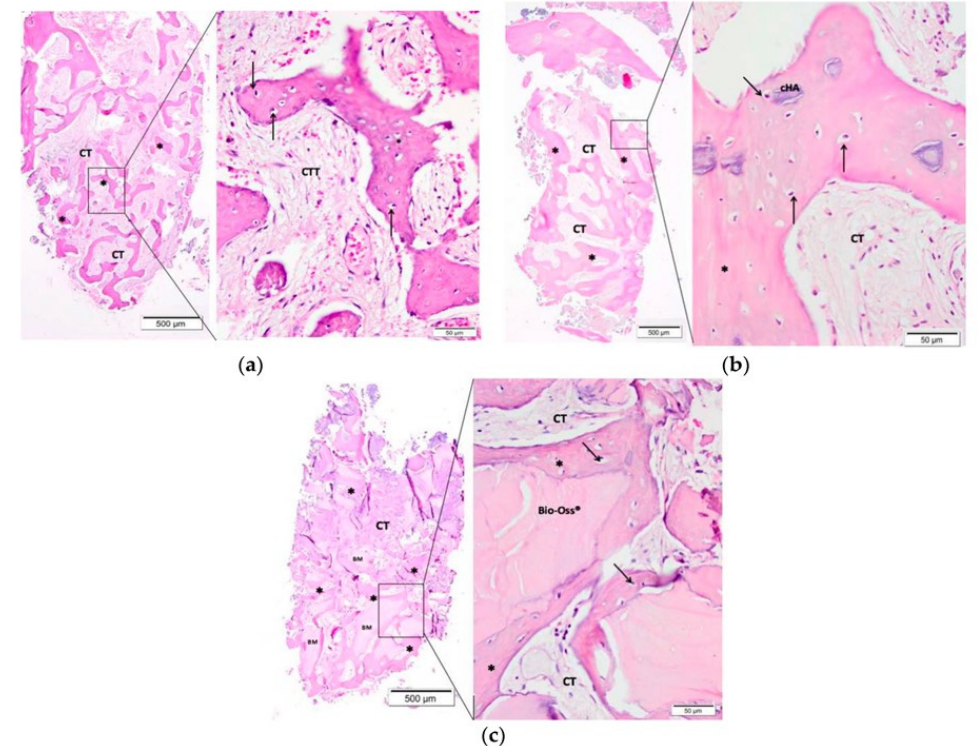
Figure 15. Microscopic images of the alveolar socket after 90 days of biomaterial implantation: ( a ) Control group (Clot), ( b ) carbonated hydroxyapatite group, and ( c ) Bio-Oss ® group. The small squares are displayed at 40-fold magnification adjacent to the figures with lower magnification. Connective tissue (CT/CIT); (*) new bone formation; osteoblast pavement (black arrow); carbonated hydroxyapatite (CHA) and Bio-Oss ®